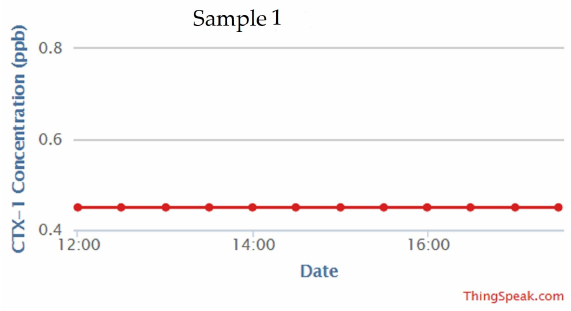
Figure 9. Real time data of CTx-I from the developed PoC device.